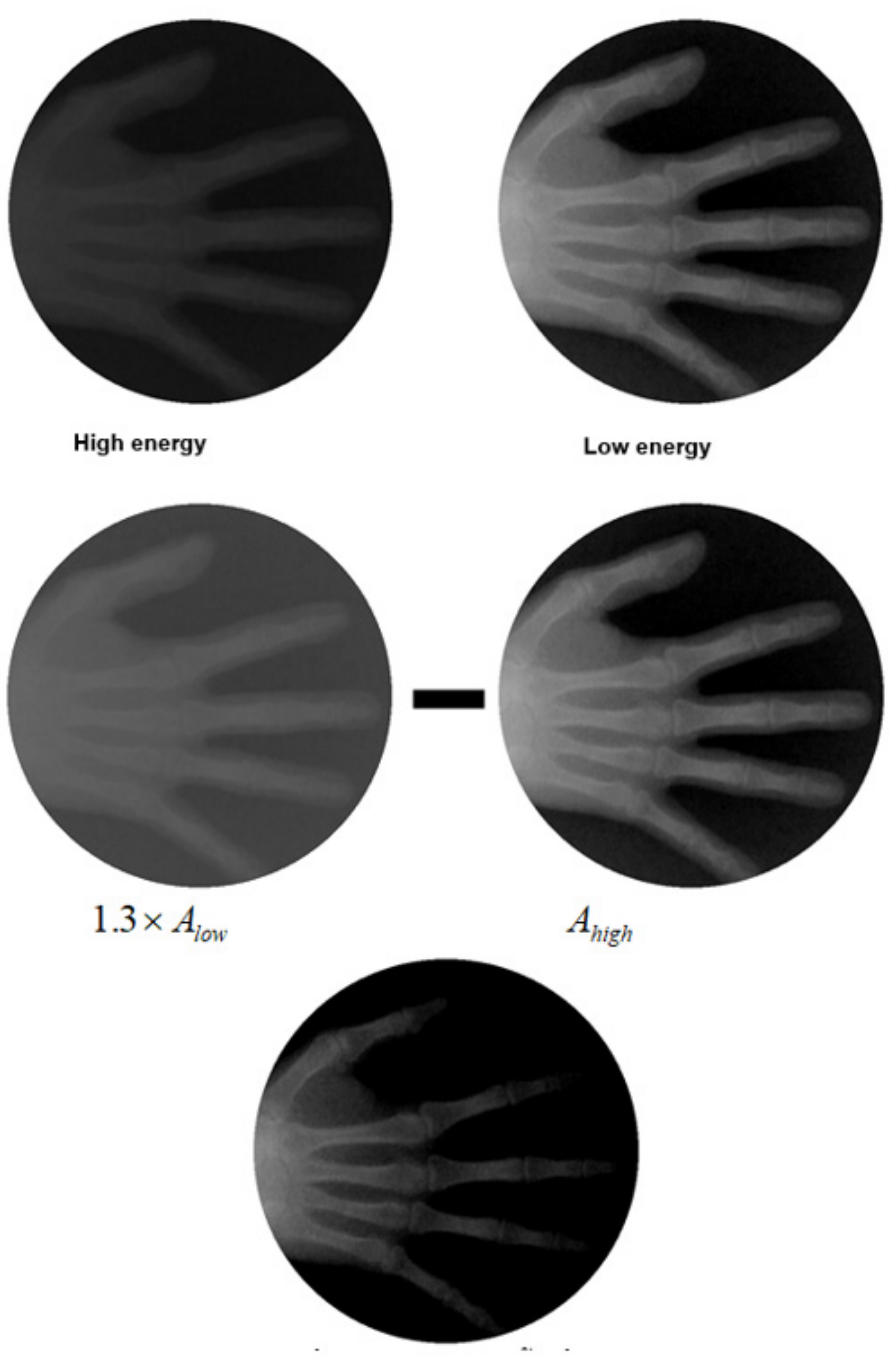
Figure 6. Process of determining k . By subtracting the high-level detector image from k multiplies the low-level detector image, k is adjusted until no soft tissue appeared on the subtracted image (the bottom).